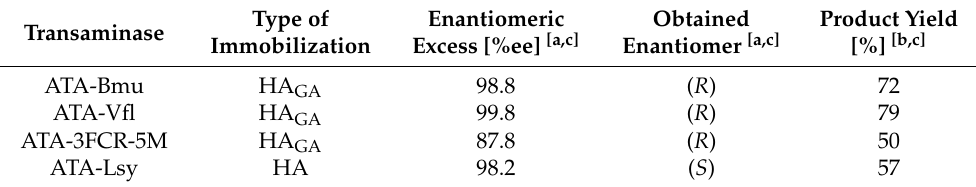
Table 2. Upscaled kinetic resolution of rac -1-PEA catalyzed by immobilized transaminases. The best immobilizates of each transaminase (Table 1) were used in upscaled kinetic